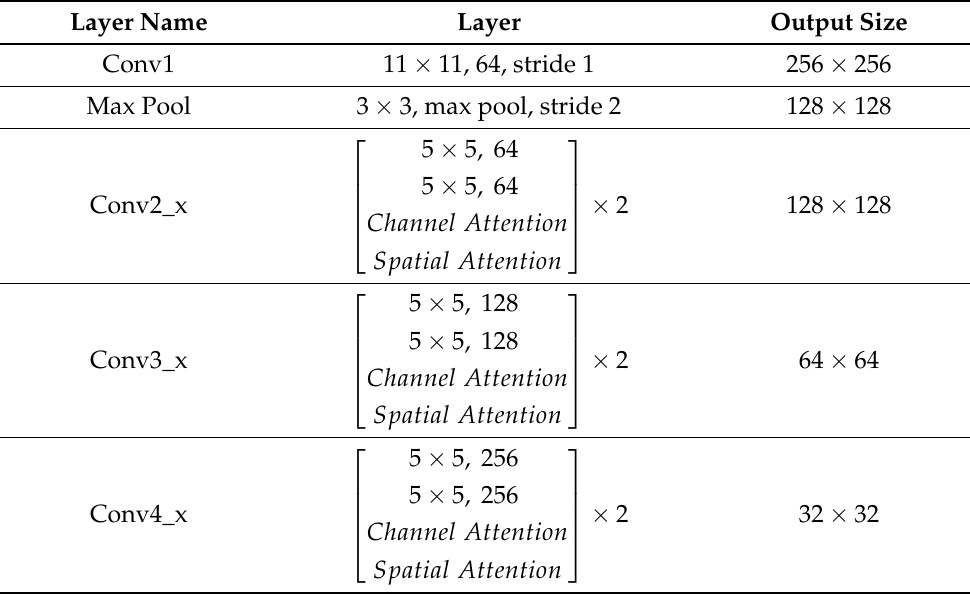
Table 1. The architecture of the deep residual network embedded with the attention